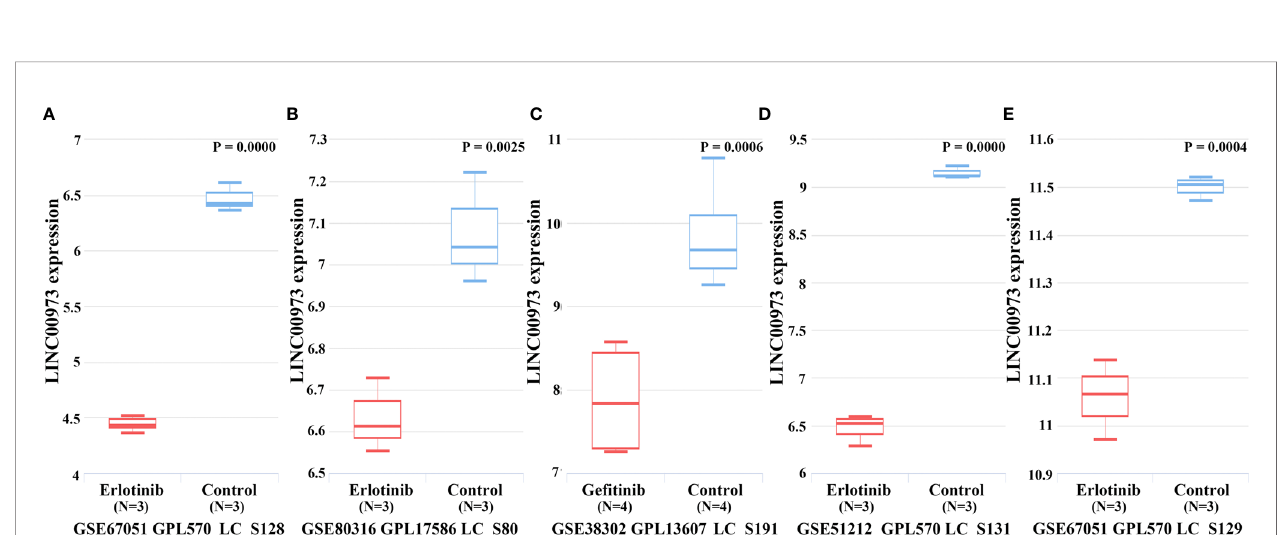
FIGURE 4 | Anti-cancer drugs could down-regulate the expression of LINC00973. (A) GSE67051-erlotinib; (B) GSE80316-erlotinib; (C) GSE38302-ge fi tinib; (D) GSE51212-erlotinib; (E)